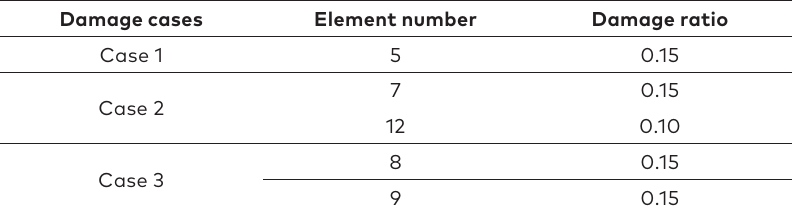
Table 1. Different damage cases for a 15-element truss